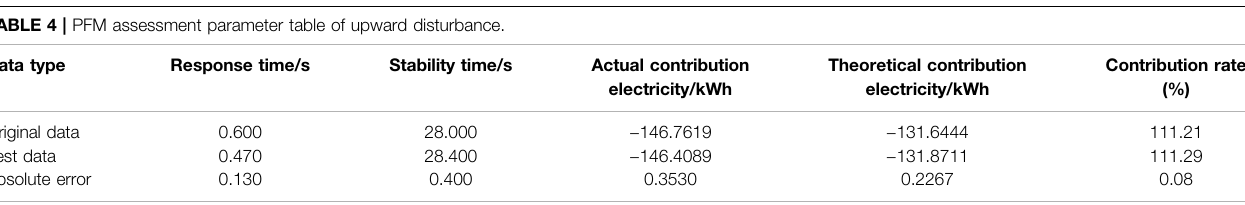
TABLE 4 | PFM assessment parameter table of upward disturbance.